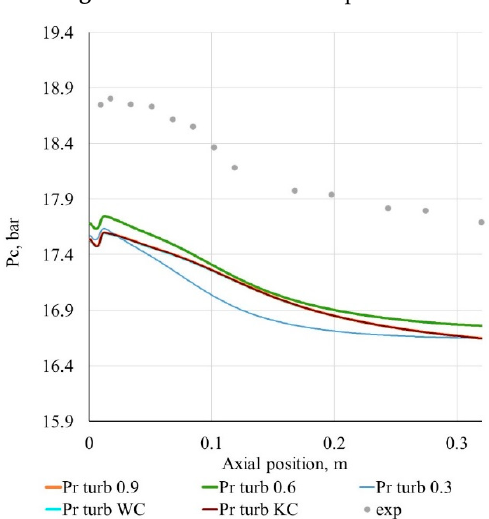
Figure 19. Absolute pressure axial distribution.